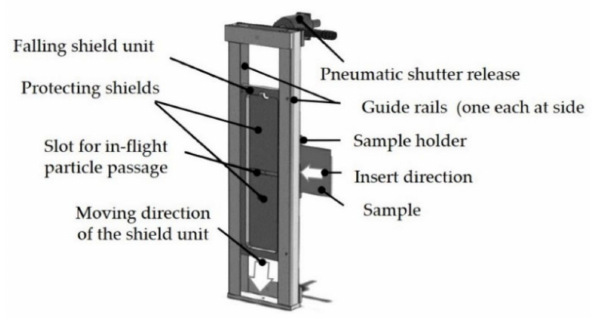
Figure 2. Beam shutter for splat investigation through a short-time exposure of a static spray